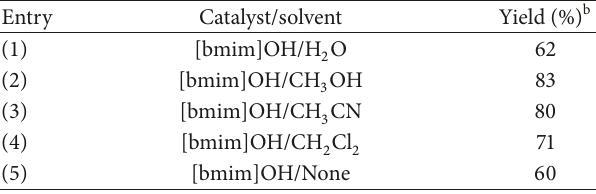
Table 1: Effects of [bmim]OH/solvent on the synthesis of DVDPA.